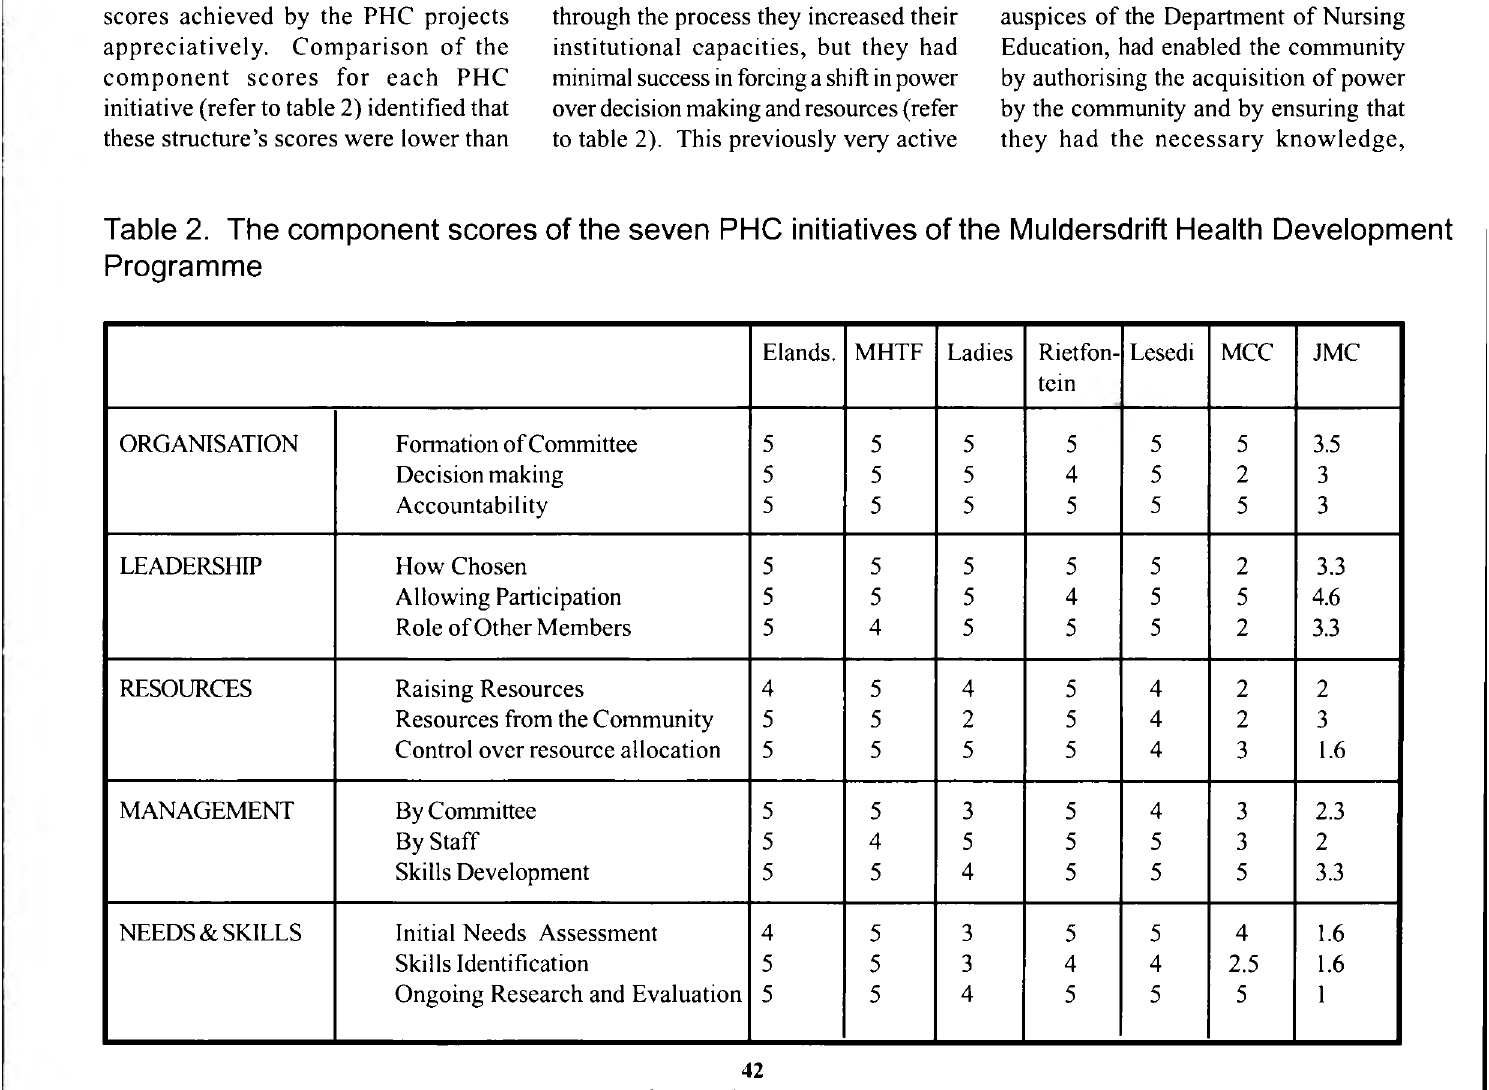
Table 2. The component scores of the seven PHC initiatives of the Muldersdrift Health Development Programme